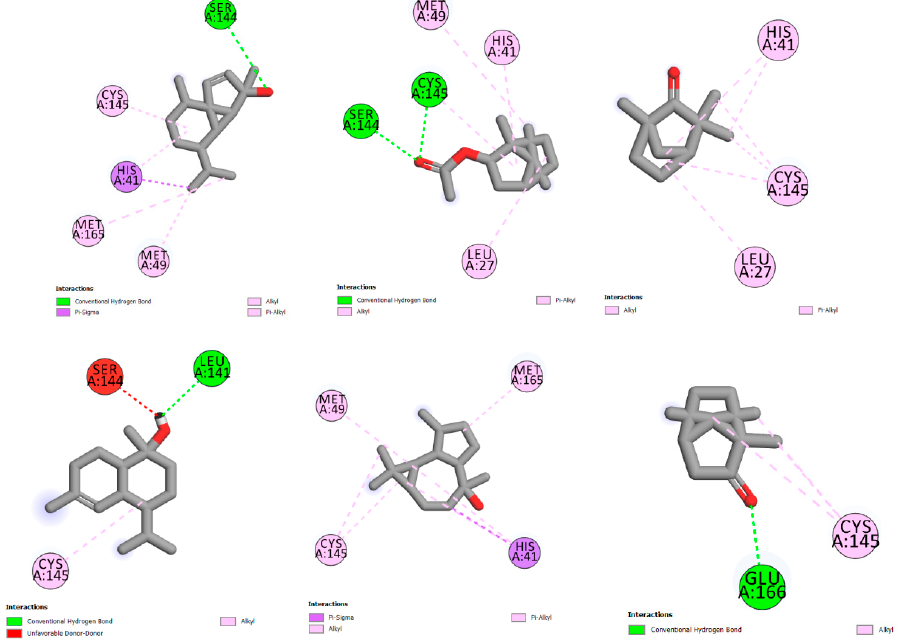
Figure 4. The molecular interactions between the studied compounds and main protease Mpro receptor (pdb:6lu7) using discovery studio visualizer. The molecular docking of compounds with the spike glycoprotein (pdb:6vsb) recep- tor presented in Figure 5 shows pi-alkyl interactions between bornyl acetate and LEU C:293 and PHE C:58 and PHE C:59 residues, with a score of 3.55 ( − 5.53 with Chimera Vina). The compound cubebol is stabilized by two hydrogen bond interactions, with ASN C:606 and LYS C:300 residues. In addition, the presence of pi-alkyl interactions increases the stability of this compound in the receptor pocket, with a score of 3.37 ( − 5.6 with Chi- mera Vina). L-fenchone is stabilized by pi-alkyl interactions, with a score of 2.54 ( − 4.8 with UCSF Chimera). The three compounds tau-muurolol, viridi fl orol, and camphor show a hydrogen bond interaction with the ARG B:1224 residue for the two fi rst compounds and with the ARG B:1226 residue for camphor.